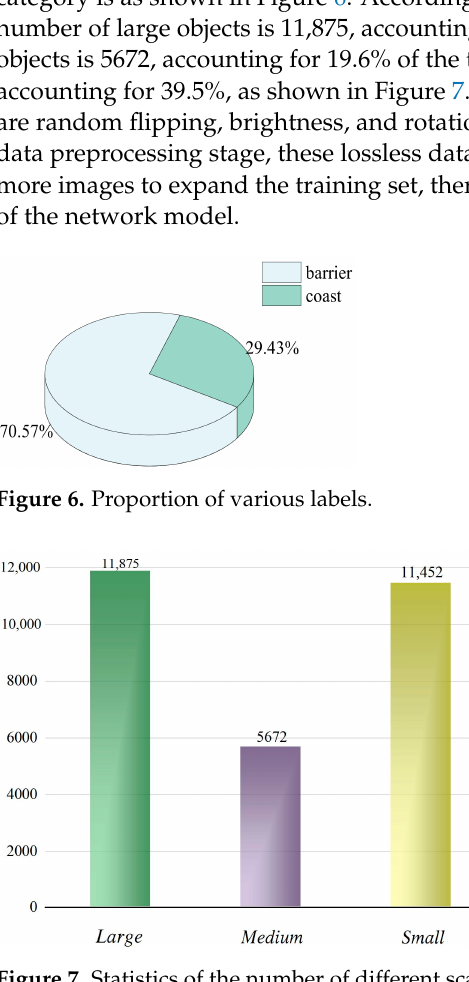
Figure 7. Statistics of the number of different scale